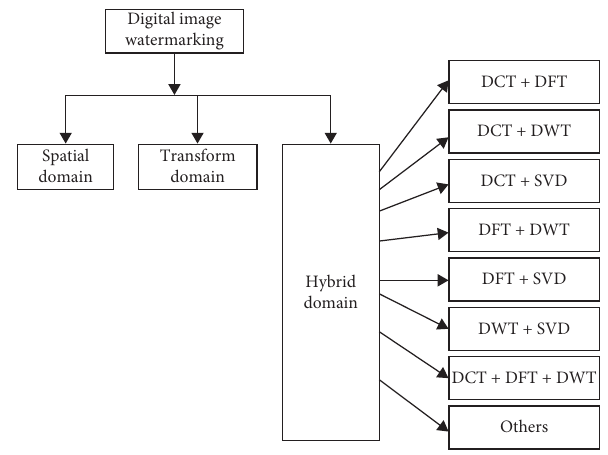
Figure 4: Classification of digital image